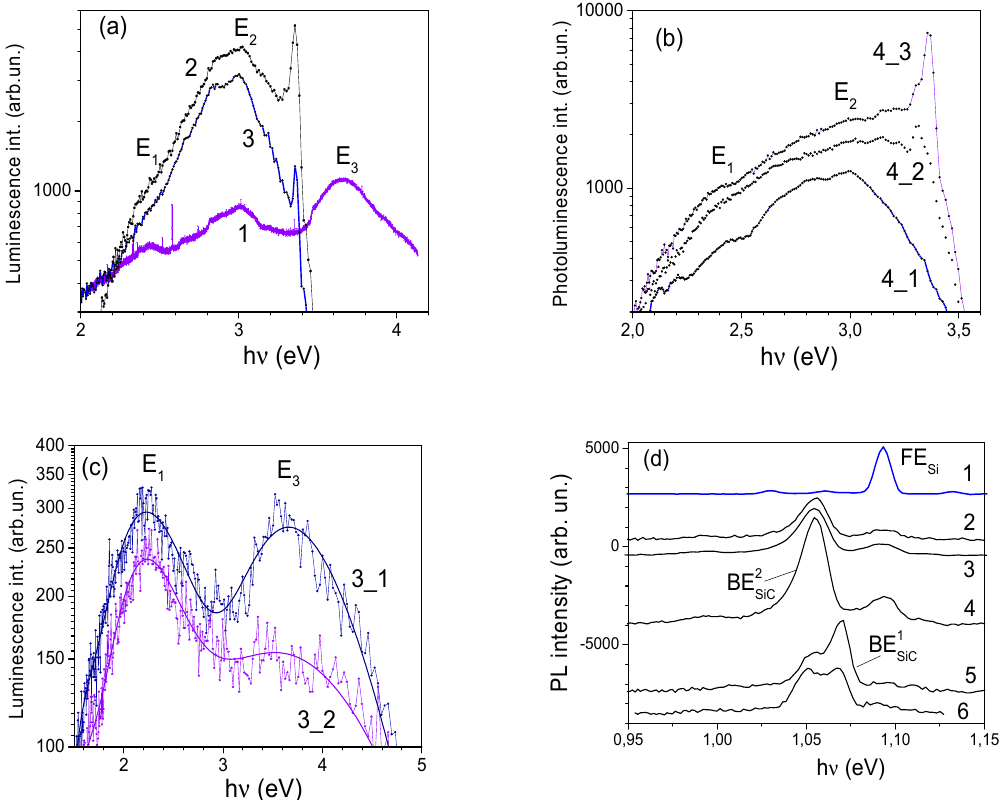
Figure 3. Photoluminescence spectra ( a , b ) from (sample 1,2) 3C-SiC / Si(111) (curve 1,2) and (sample 3,4) 3C-SiC / Si(100) samples obtained at room (curves 1,2,4_1), 80 K (curve 4_2) and 10 K (curves 2,3,4_3) temperatures with the use of the third harmonic titan-sapphire laser (curve 1) and helium-cadmium (2,3,4_i) laser. Cathodoluminescence spectra ( c ) of the sample 3: curve 3_1 from surface of the individual 3C-SiC(100) island and curve 3_2 from a surface of the solid carbonized 3C-SiC sublayer . Near infrared spectra ( d ) at a temperature of 6 K for the Si layer (1) and for the 3C-SiC / Si(100) structures grown from hexane (5), from hexane and silane (2,4) and from hexane, silane and germane (3,6) under similar other